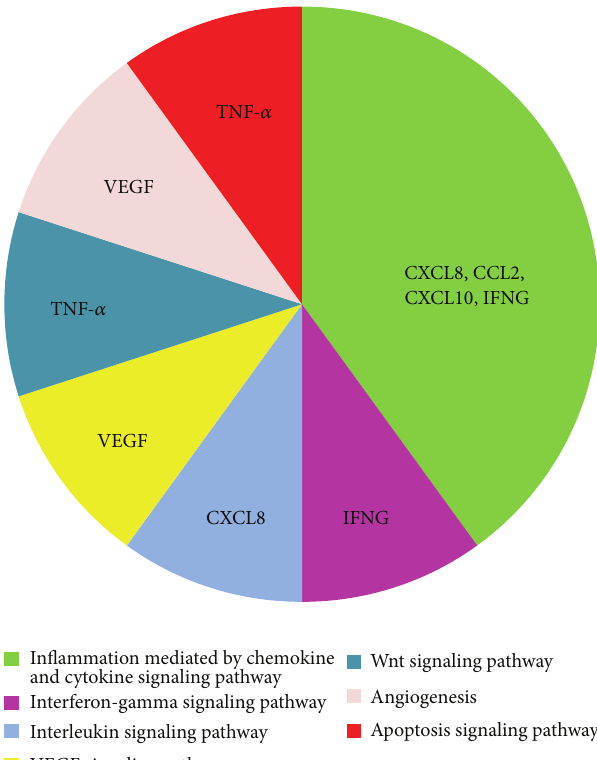
Figure 3: PANTHER pathway analysis in which we show the pathways related to the following six significant proteins: CXCL8 (C-X-C motif ligand 8), CCL2 (C-C motif ligand 2), VEGF (vascular endothelial growth factor), IFNG (interferon gamma), CXCL10 (C-X-C motif ligand 10), and TNF- 𝛼 (tumor necrosis factor alpha).